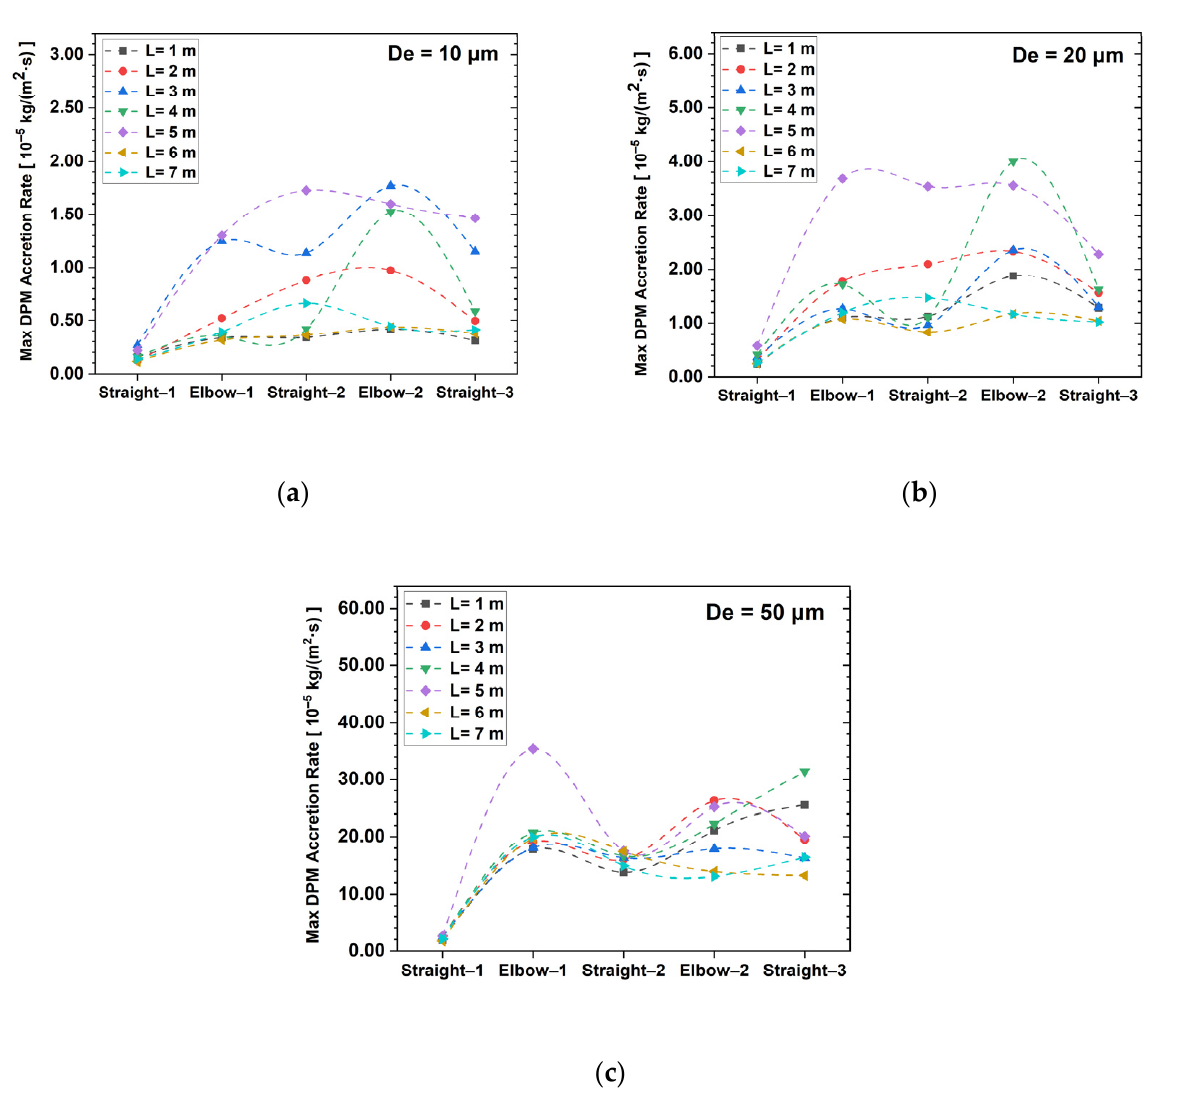
Figure 11. The max accretion rate varies with the location of different computation domains: ( a ) The average particle size is 10 μ m; ( b ) The average particle size is 20 μ m; ( c ) The average particle size is 50 μ m.